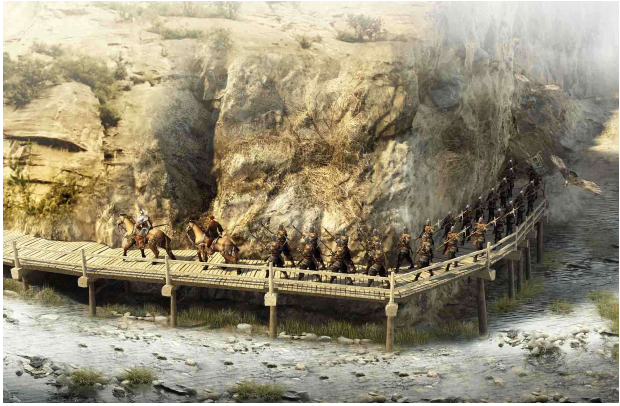
Figure 14. Result of the virtual restoration for the Chiya Plank Road.